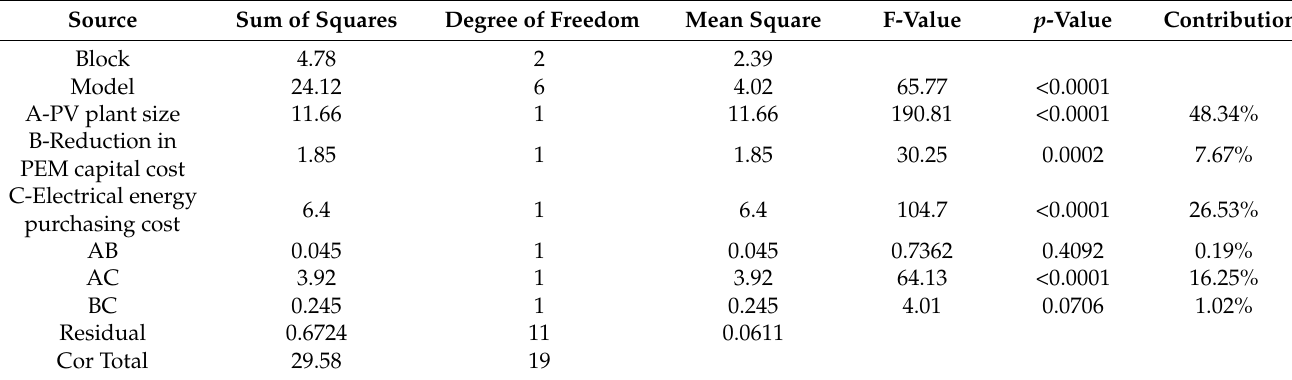
Table 9. ANOVA for the 2FI model.